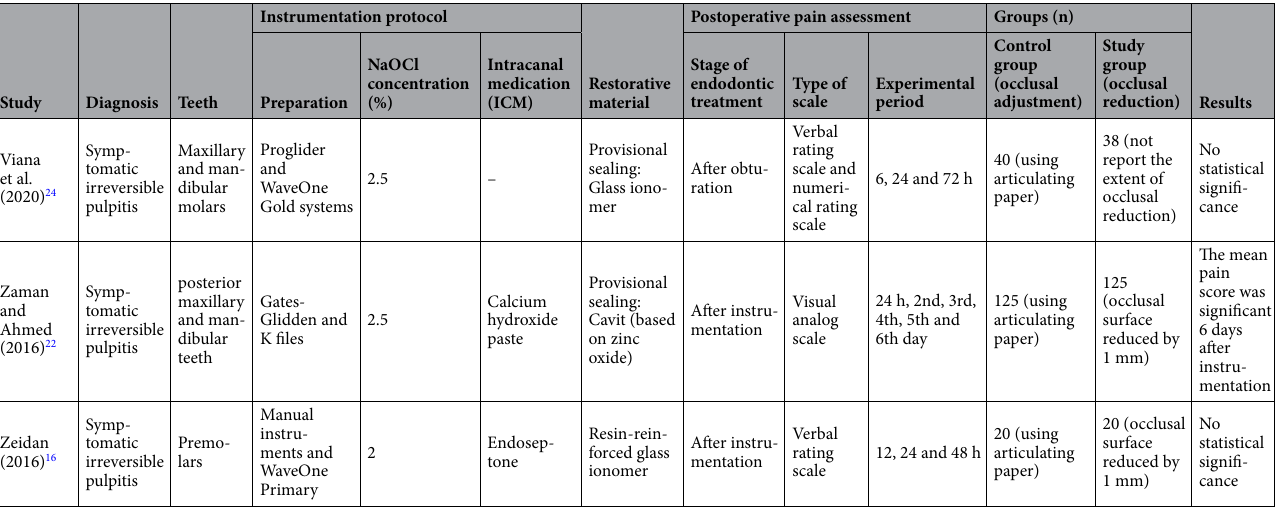
Table 2. Evidence table summarizing the characteristics of the included